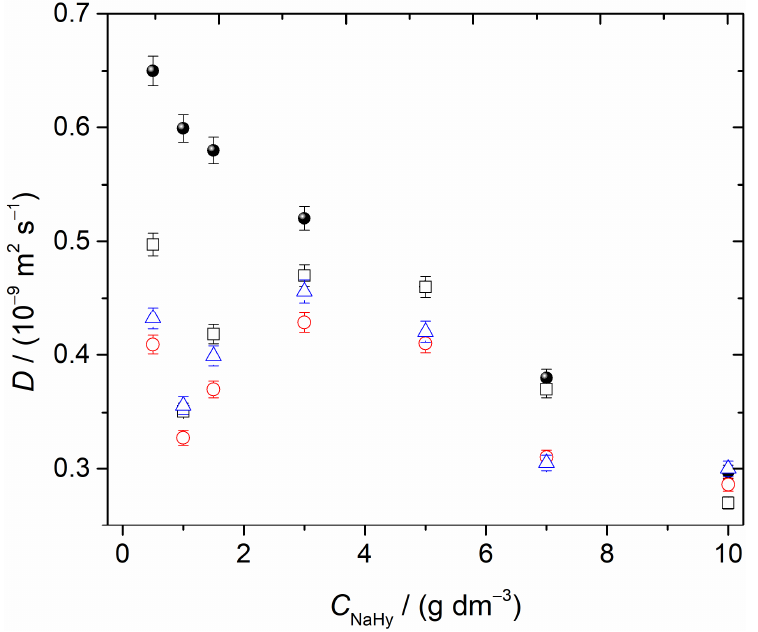
Figure 2. Tracer diffusion coefficients of NaHy in water ( • ) and in solutions with different concentrations of β -cyclodextrin at 25.00 ◦ C: ( (cid:3) ) 0.001 mol dm − 3 ; (o) 0.005 mol dm − 3 ; and ( ∆ ) 0.007 mol dm − 3 .